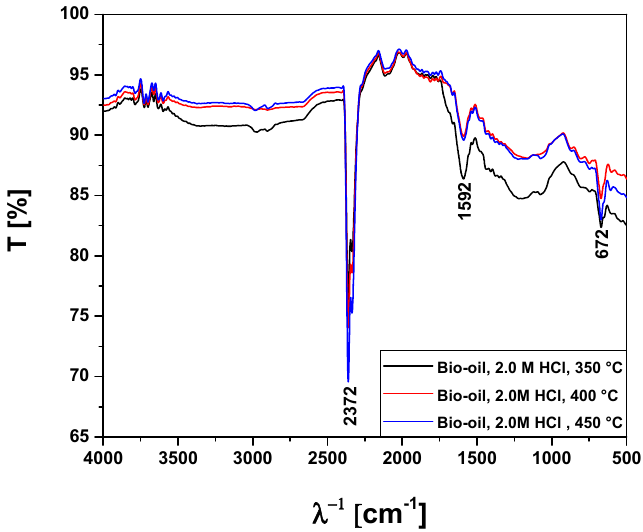
Figure 10. FT-IR analysis of bio-oils obtained by pyrolysis of Açaí seeds, activated with 2.0 M HCl solution, at 350, 400, and 450 °C, 1.0 atmosphere, in laboratory scale.